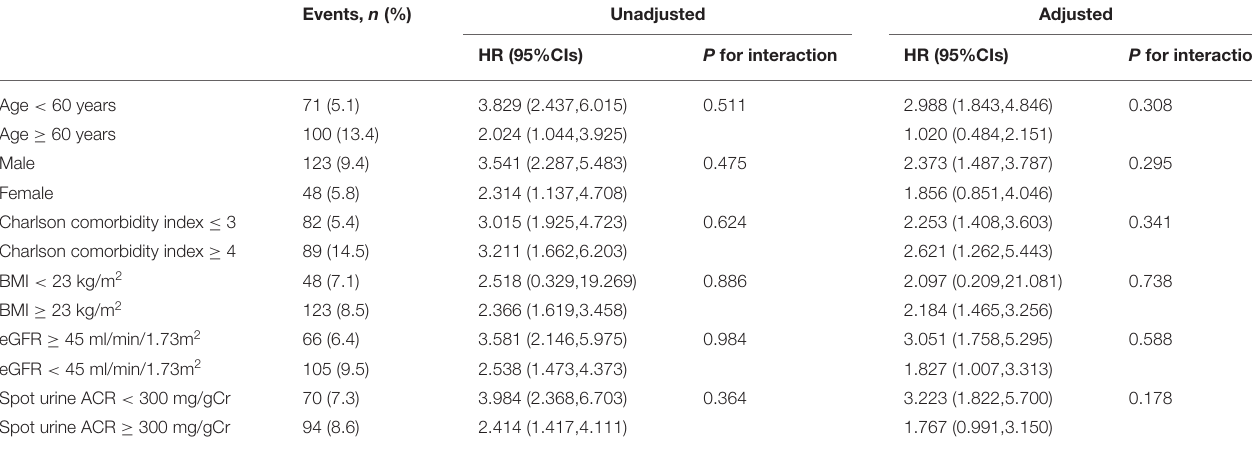
TABLE 4 | Cox regression analysis of LVDD ( E / e ′ > 14) for the risk of cardiovascular (CV) events in various